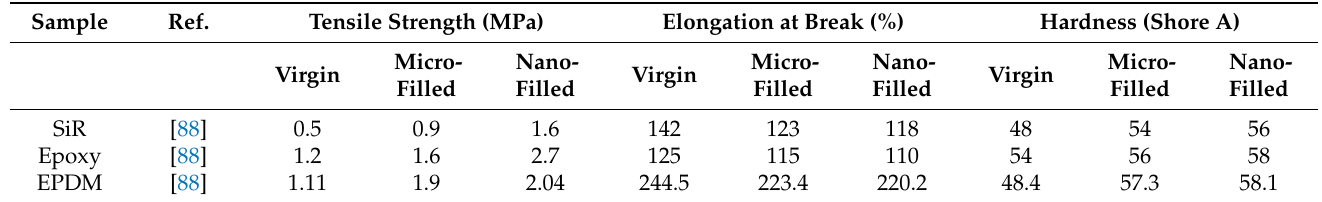
Table 4. Mechanical properties of SiR, epoxy and EPDM filled with micro and nano SiO 2 fillers. Sample